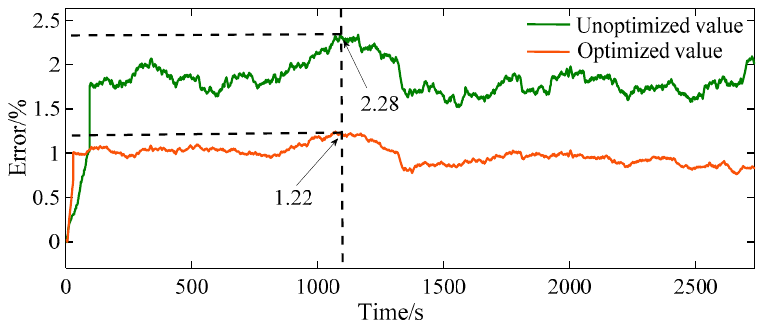
Figure 15. SOC estimation error before and after optimization of the model parameters.